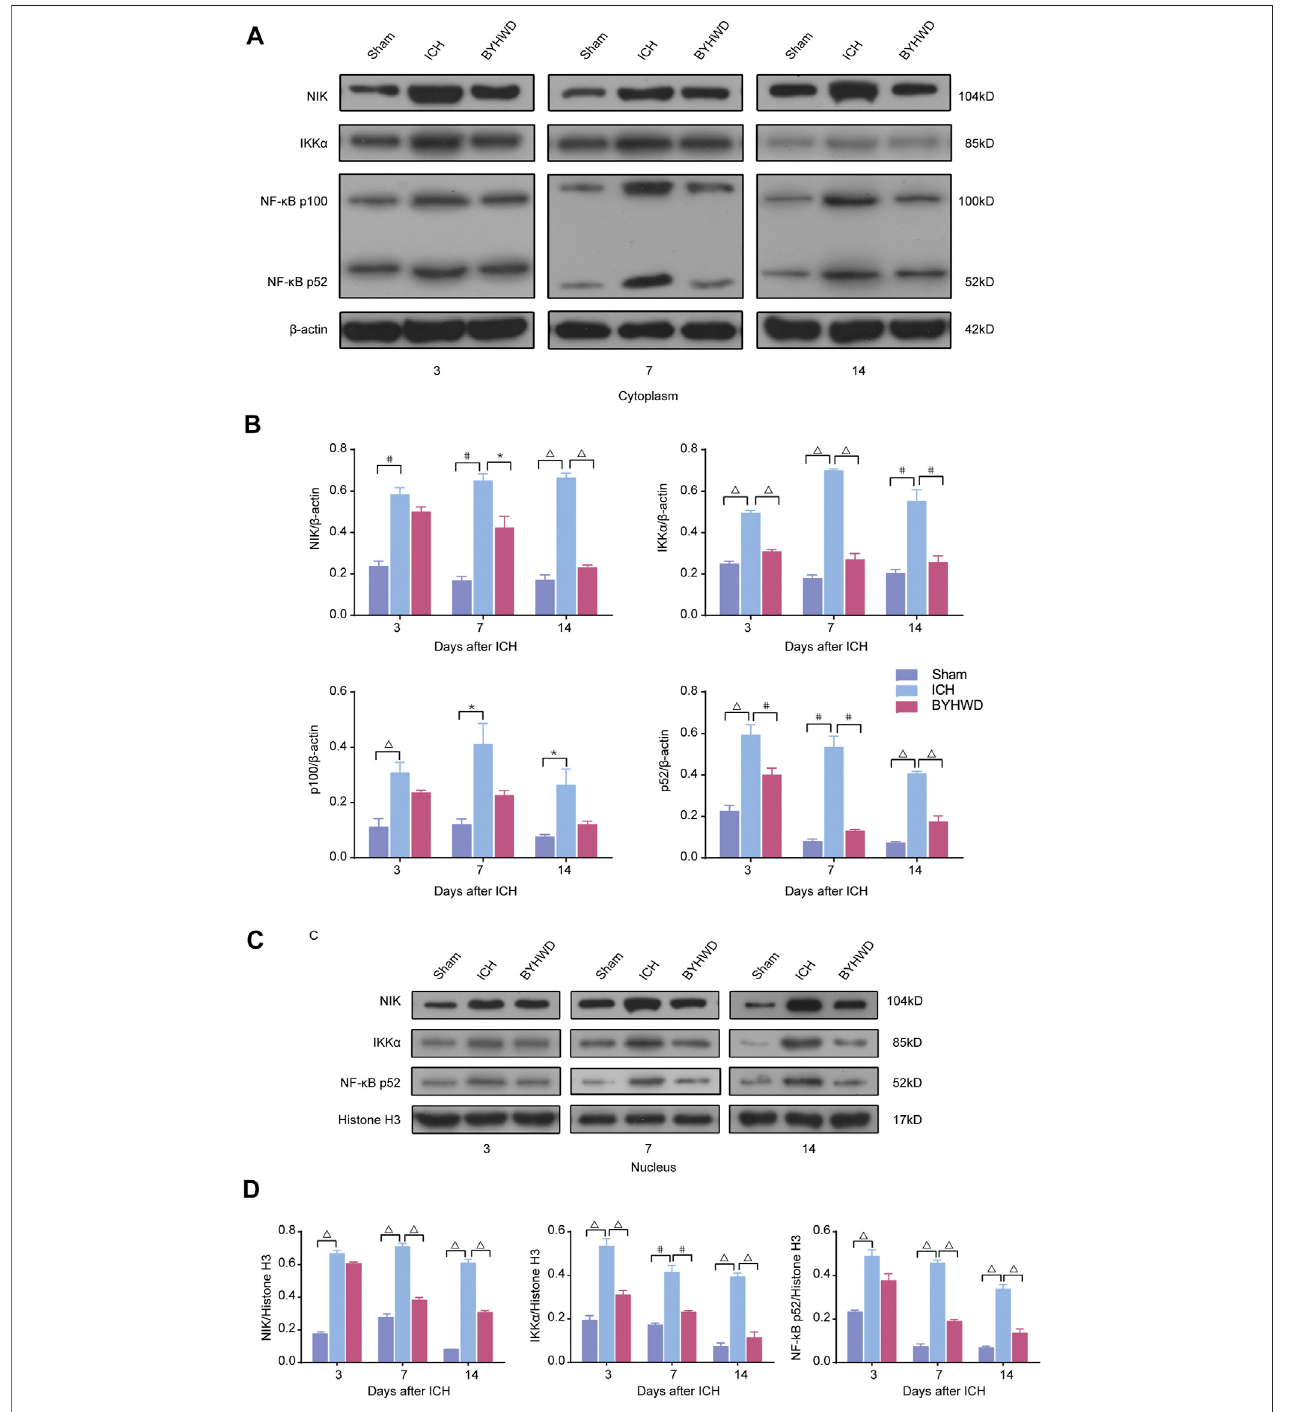
FIGURE 3 | NIK was highly expressed in ICH rats ’ brain tissues and BYHWD inhibited the activity of the noncanonical NF- κ B signaling after ICH. Activation of the noncanonical NF- κ B pathway on days 3, 7, and 14 after ICH in cytoplasm and nucleus. A representative immunoblot showed the effects of ICH and BYHWD on the protein levels of key factors, NIK, Ikk α , NF- κ B p100, and NF- κ B p52, in the noncanonical NF- κ B pathway in cytoplasm (A) and the nucleus (C) at the ipsilateral tissue. Relative expression of NIK, Ikk α , NF- κ B p100, and NF- κ B p52 protein in cytoplasm (B) and NIK, Ikk α , and NF- κ B p52 protein (D) in the nucleus. Data are the mean ± SEM ( n (cid:2) 6 each group); * p < 0.05, # p < 0.01, Δ P < 0.001 deemed as signi fi cant difference.